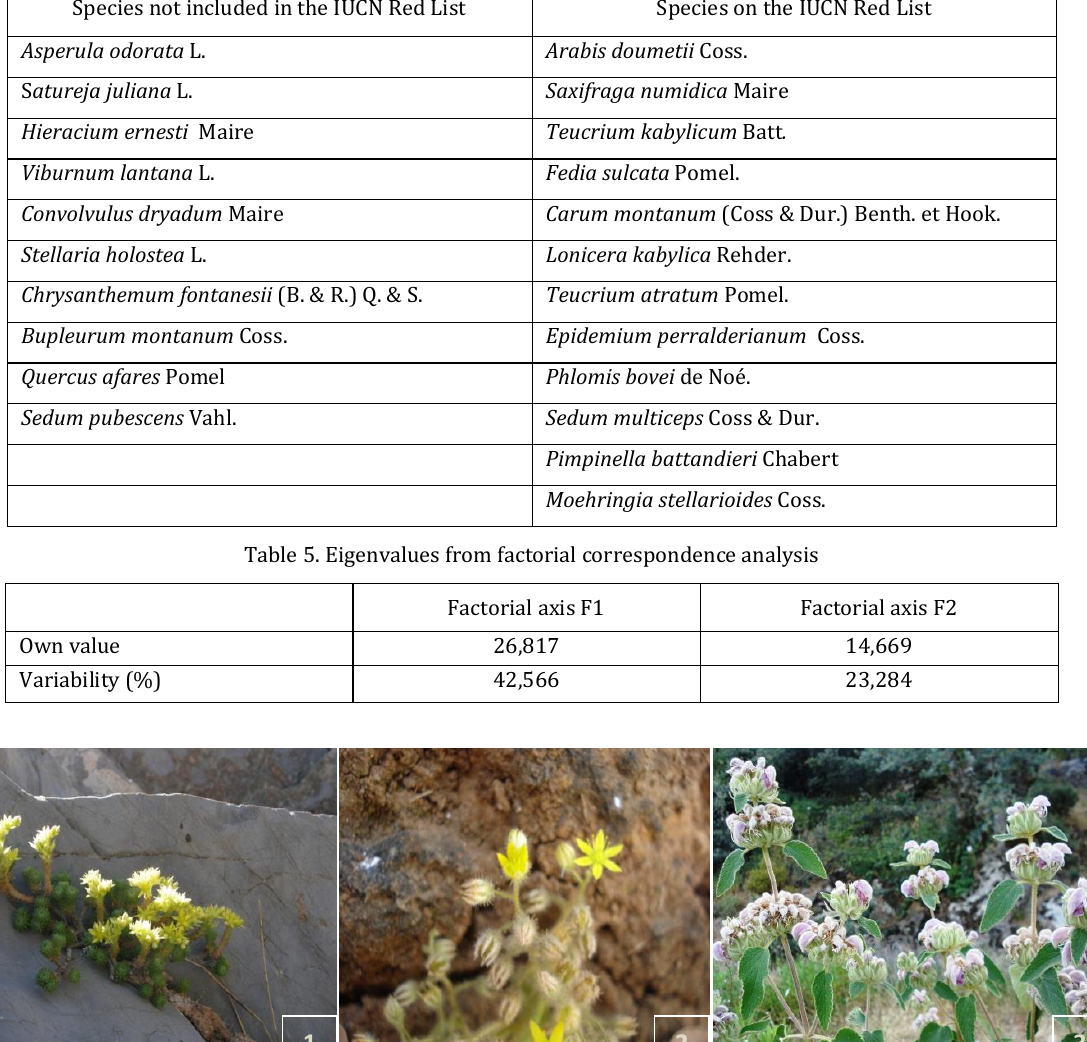
Table 4. Rare and threatened species of the Guerrouche Forest Species not included in the IUCN Red List Species on the IUCN Red List Asperula odorata L.